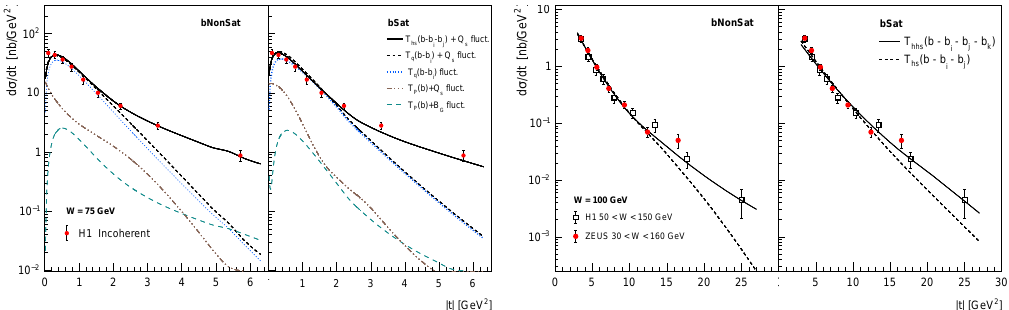
Figure 2: The | t | dependence of incoherent J / Ψ photoproduction in refined hotspot